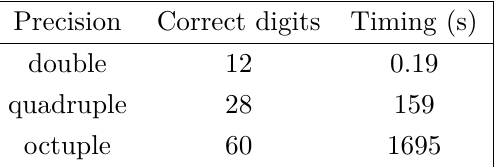
Table 6. Evaluation times of all one-mass pentagon functions on a typical phase-space point.